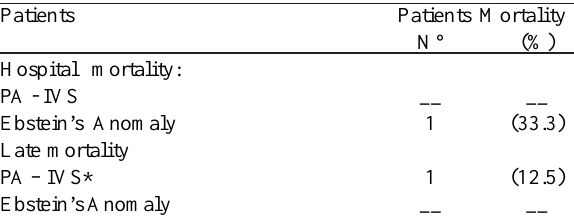
Table 3. Surgical results.